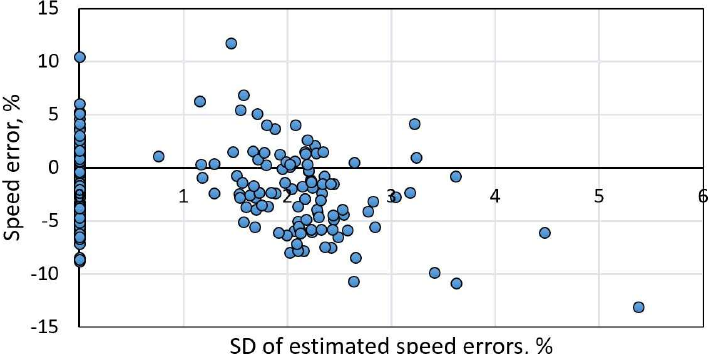
Figure 9. Relative speed error versus standard deviation (SD) of estimated speed error values by applying peak suppression with five different rescaling coefficients.